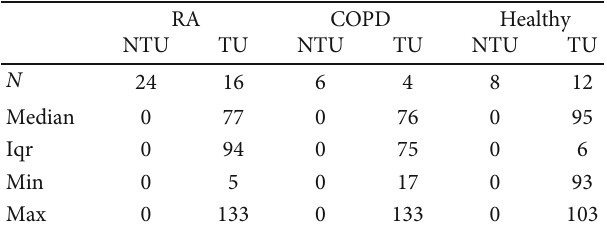
Table 2: Cotinine levels (ng/ml) of the RA and control